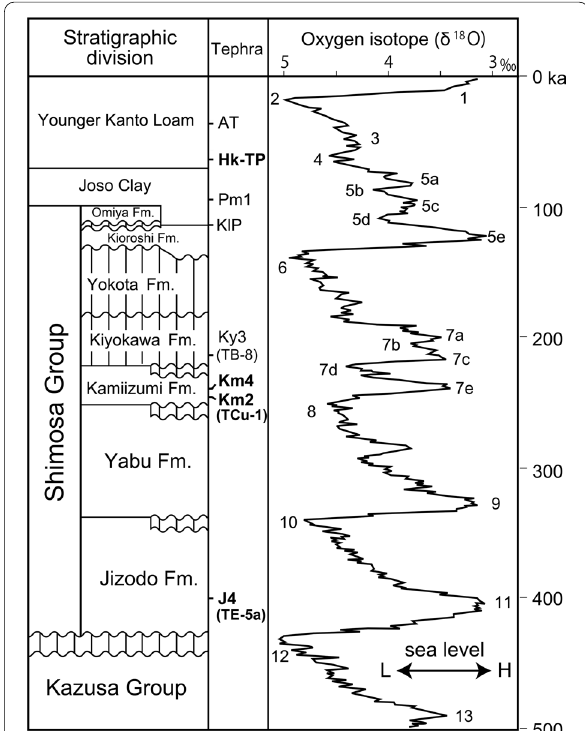
Fig. 2 Stratigraphic summary of the Pleistocene Shimosa Group and correlation with MISs. The stratigraphic framework and depositional age summarised in Nakazawa and Tanabe (2011) are shown in the left column. Among the widespread tephra beds in the Shimosa Group, those detected in core GS-UR-1 (J4, Km2, Km4, and Hk-TP) are shown in bold (Nakazawa and Nakaszto 2005). The Yokota and Kiyokawa formations shown in shaded boxes are lacking due to the erosion during MIS 6 at the core site of GS-UR-1 (Nakazawa and Nakaszto 2005). The marine oxygen isotope curve is adapted from Lisiecki and Raymo